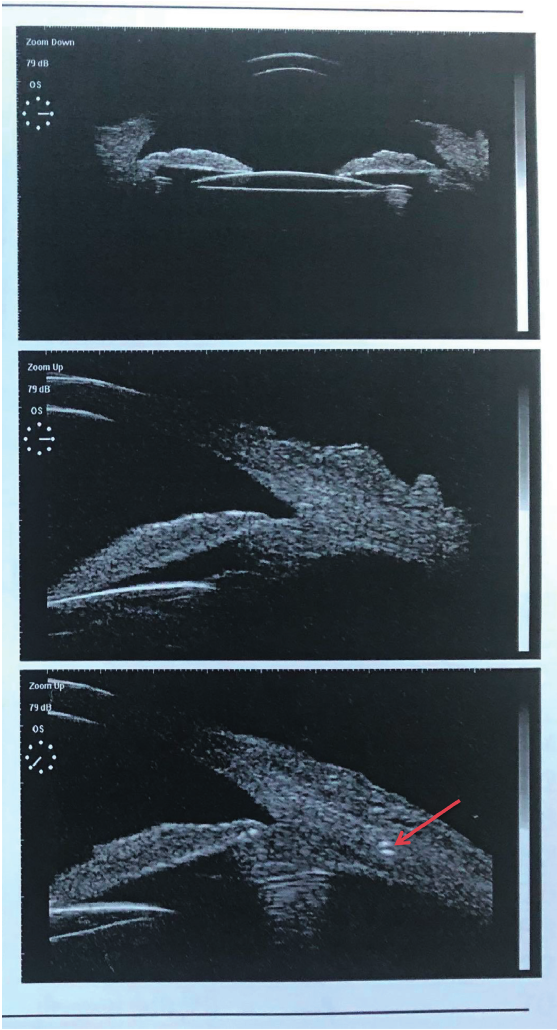
Figure 2: The typical UBM images in a patient 3 months after the transscleral-sutured IOL implantation (tunnel containing the su- tures was clearly detected by UBM (red arrow)).